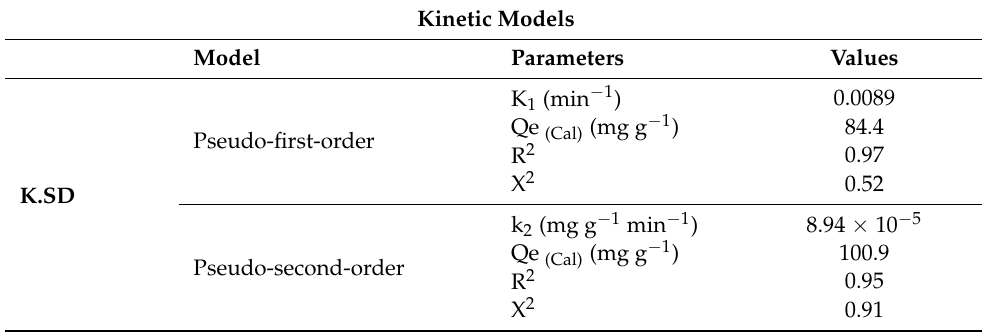
Table 3. The mathematical parameters of the studied kinetic